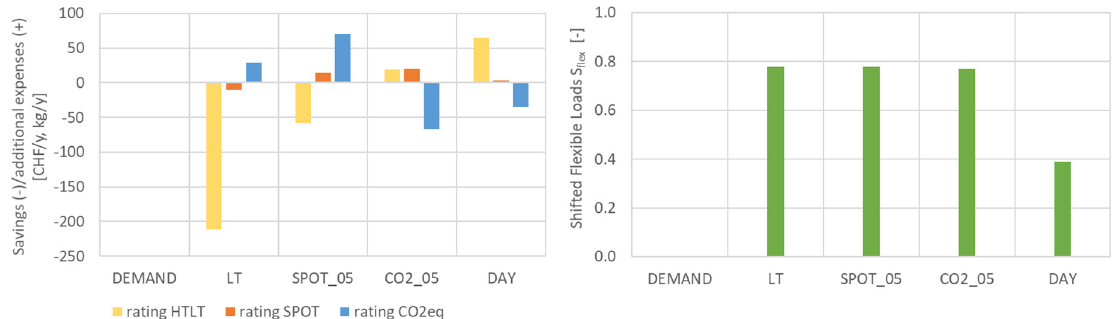
Figure 5. Savings or additional expenses ( left ) and relative shifted loads ( S flex , right ) depending on penalty signal considered and compared to the base case DEMAND.